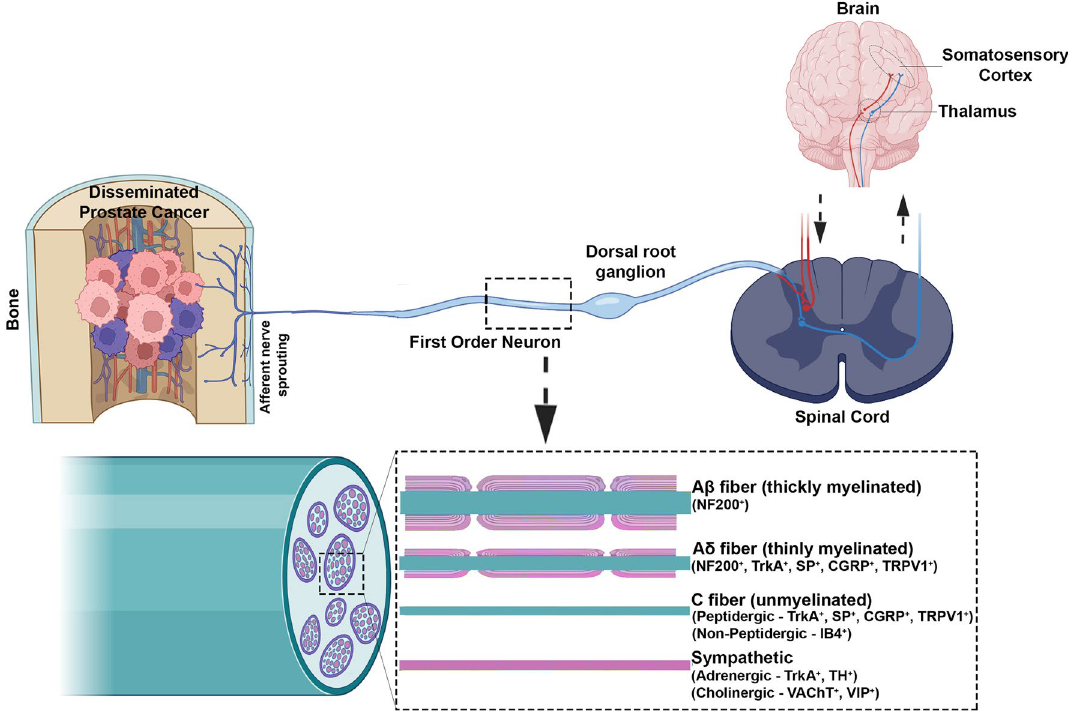
Fig. 1 Primary afferent sensory nerve fibres primarily in the periosteum but also in the bone marrow of prostate cancer invaded bone undergo pathobiological sprouting and sensitization with pronociceptive signalling transduced into the dorsal horn of the spinal cord, from where it projects to the brain where it may be interpreted as pain (Created with